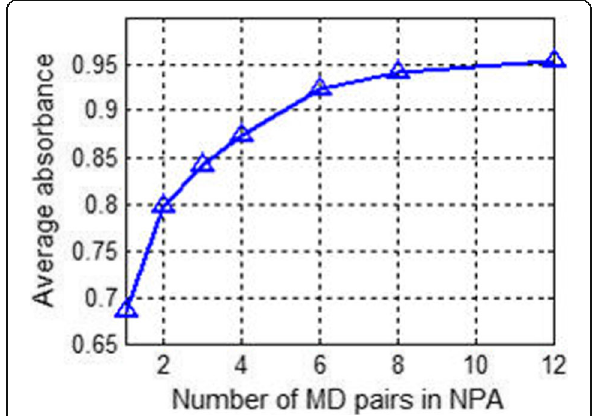
Fig. 4 Average absorbance as a function of the number of MD layers